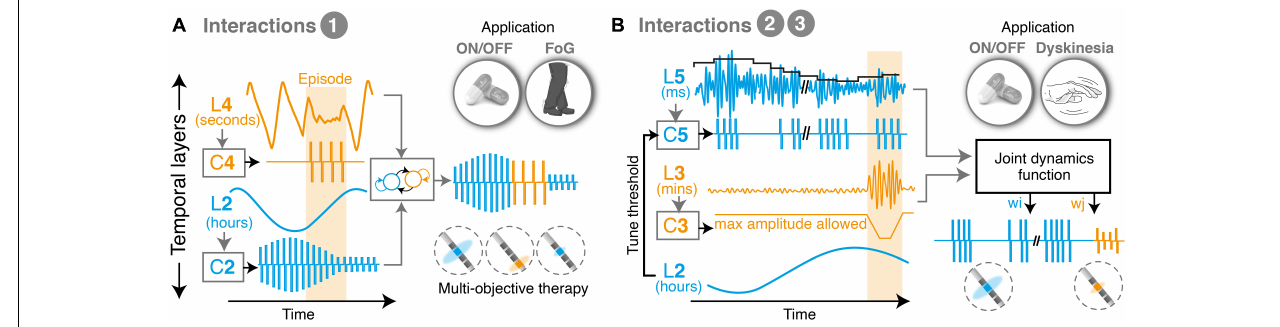
FIGURE 3 | Illustrative examples of multi-objective therapies. (A) Example of state machine controller, which transitions between two different low-level control loops and interleaves two therapies for symptoms overlapping in time. This approach is suitable to combine clinical manifestations that exhibit markedly different temporal time-constants, and which consequently suffer from minimal crosstalk. For instance, episodic events such as freezing of gait, which happen in the range of seconds to minutes, may be easily interleaved with therapies that control ON-OFF fluctuations, which operate in the range of hours. In this configuration, each controller independently monitors and responds to a biomarker, and delivers an output optimized for its individual manifestation. The middle level controller activates one or the other, depending on the requirements over time. (B) Example of multi-objective therapy addressing manifestations on three temporal layers (namely, beta burst activity patterns, ON-OFF fluctuations and dyskinesias). Unidirectional dependencies are used to tune the controller of one layer based on feedback from another, in this case to set a threshold for detecting beta bursts (at the millisecond range) while accounting for fluctuations in beta power over the course of the day. In parallel, a joint optimization controller computes optimal stimulation amplitudes to minimize episodic stimulation-induced dyskinesias, based on a weighted evaluation of the need to trim pathologically long beta bursts while preventing side-effects. L, temporal layer; C, controller; w, weight; ON/OFF, with/without medication; FoG, freezing of